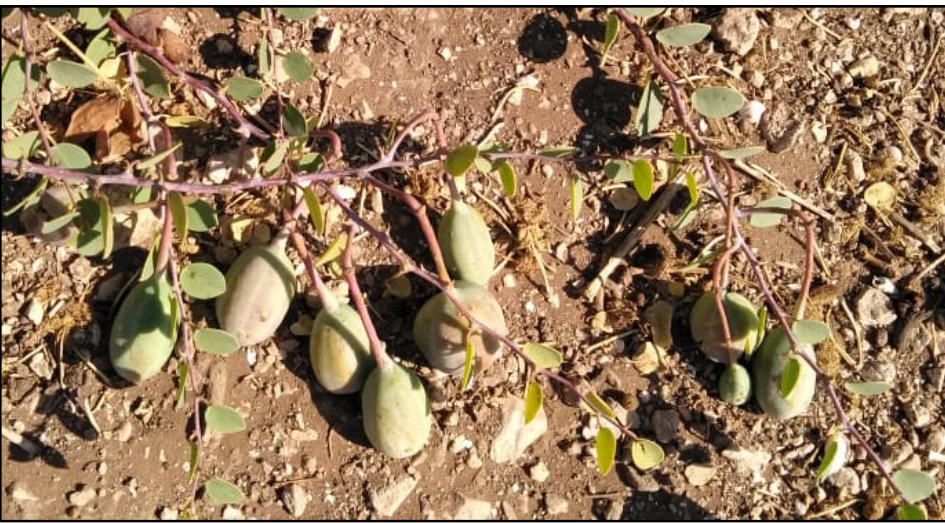
Figure 1. Caper ( Capparis spinosa L.) fruits.